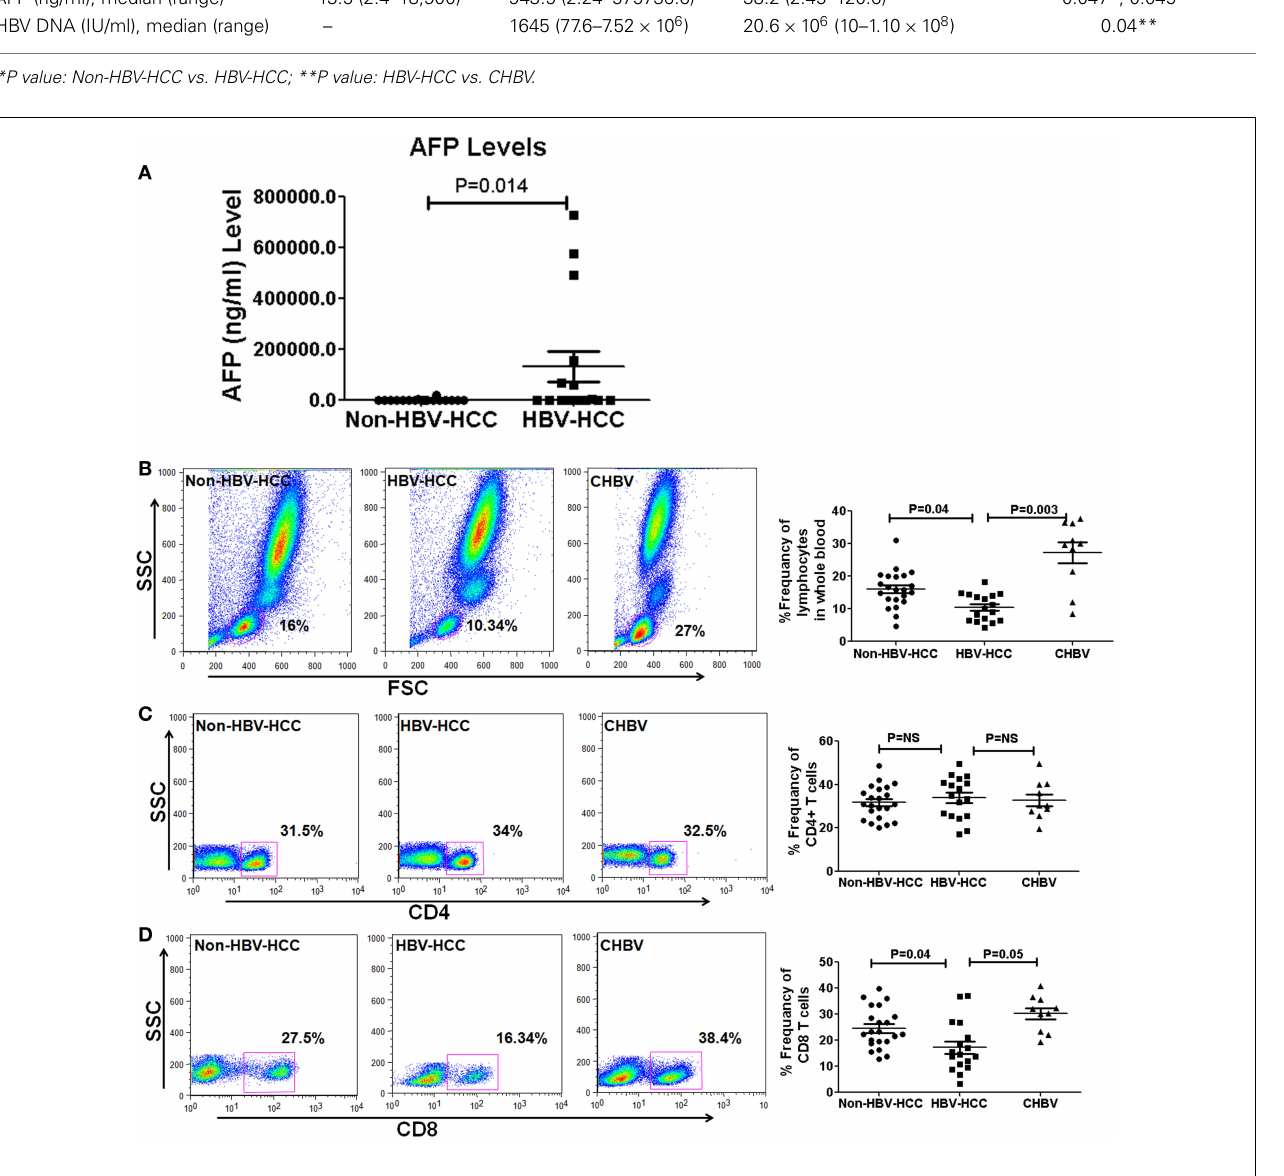
FIGURE 1 | (A) Alpha-fetoprotein level is a predictive marker of HCC and its values are high in HBVHCC than non-HBV-HCC. (B–D) Representative flow-cytometric dot plots and scatter plots showing differential frequencies of